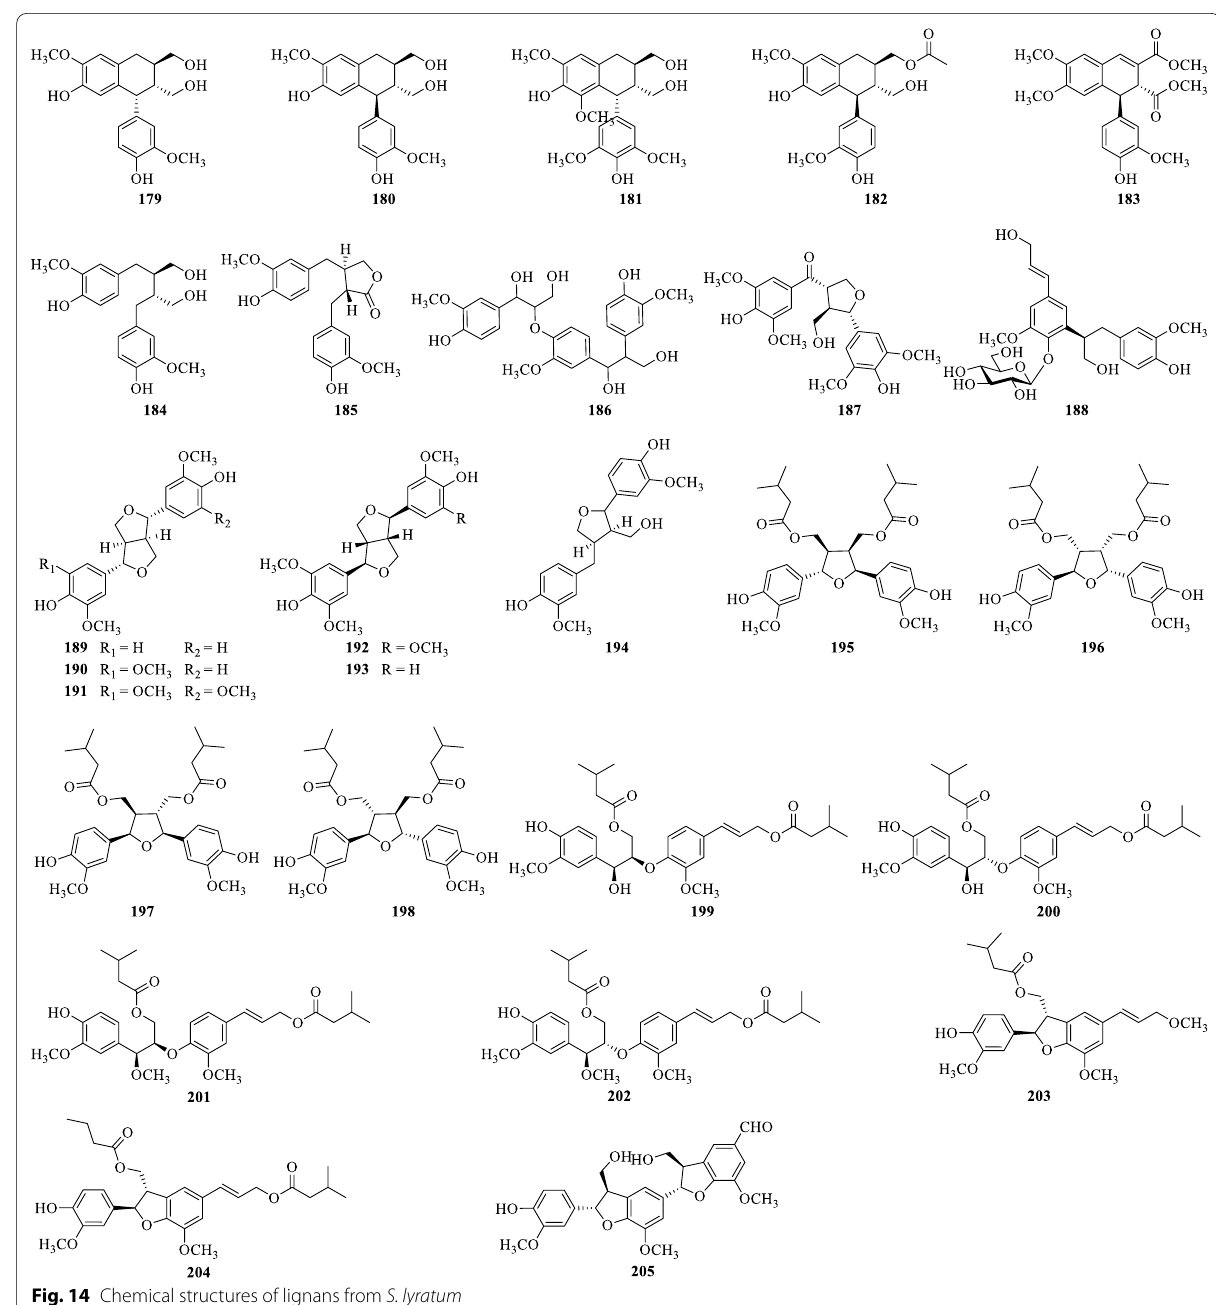
Fig. 14 Chemical structures of lignans from S.